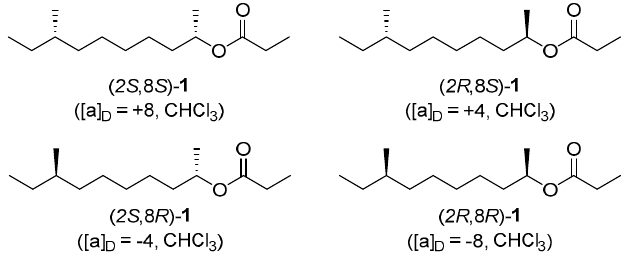
Figure 1. Four stereoisomers of the sex pheromone of the western corn rootworm ( 1 ).